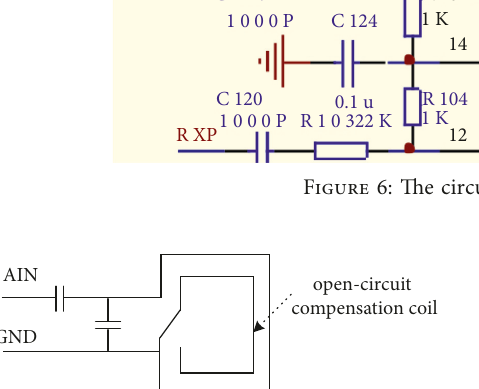
Figure 7: The antenna coil with an open-circuit compensation coil.